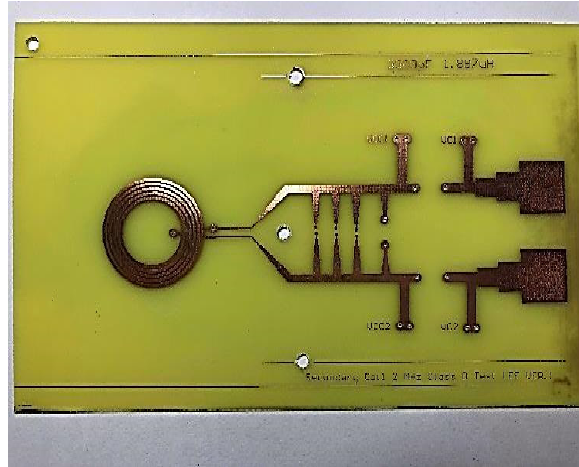
Figure 24. Primary measurement resonance coil.